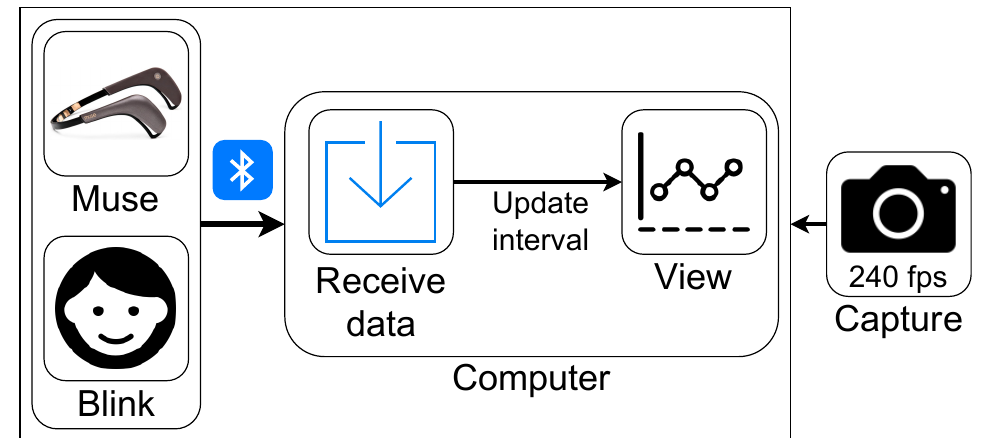
Figure 7. Design of the setup for the latency